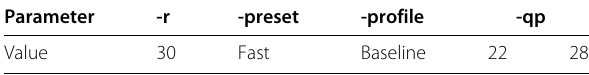
Table 1 Local transcoders with the rate control parameter of CRF Parameter